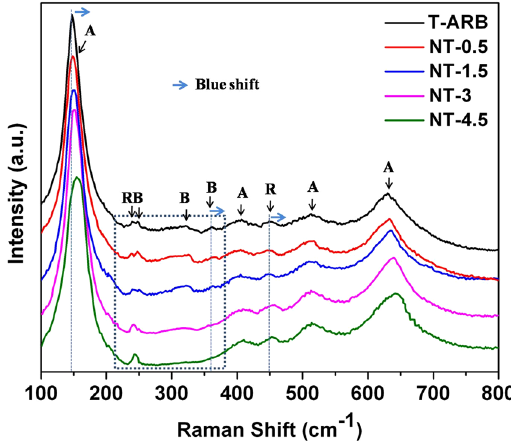
Figure 2. Raman Spectra of pristine and N-TiO 2 nanotubes.